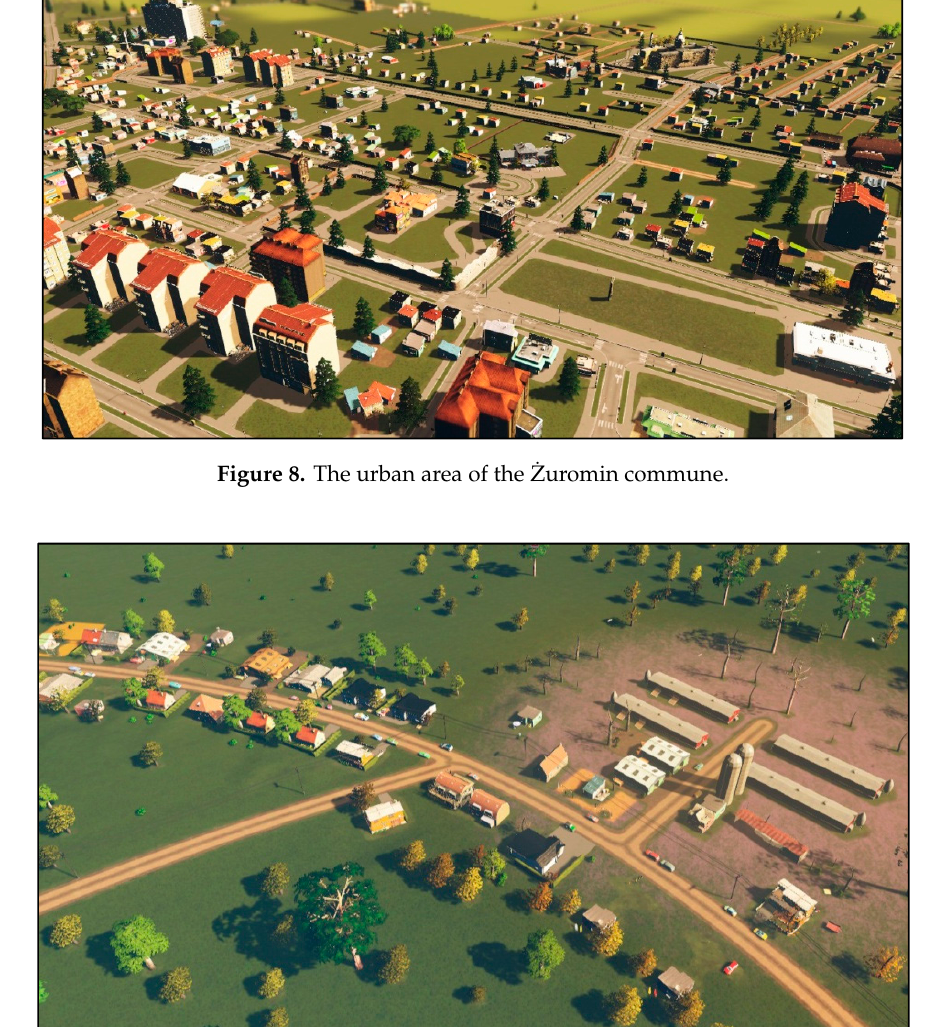
Figure 7. Farms imported into the game engine along with adjacent buildings, plants, and a road network.